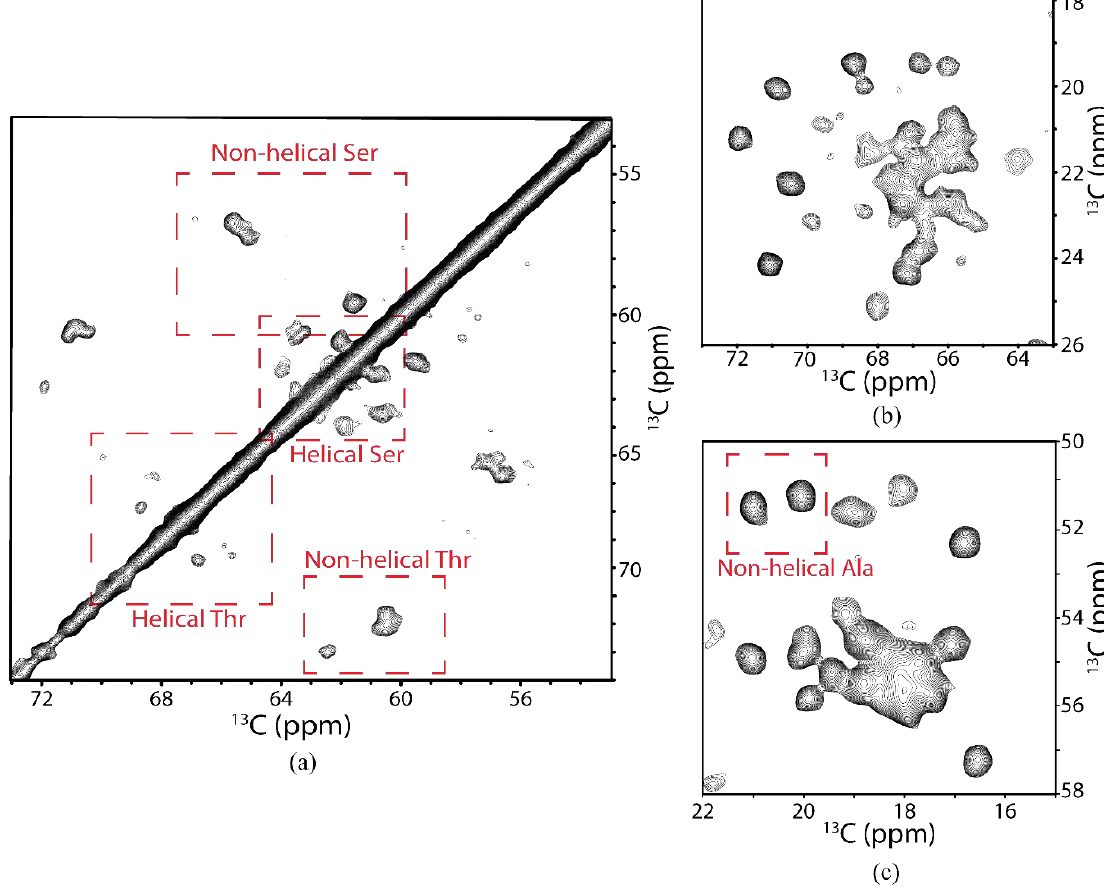
Figure 8. Selected characteristic regions of two-dimensional 13 C– 13 C DARR chemical shift correlation spectrum of 13 C, 15 N-labeled hAQP2 proteolipid complexes. Regions selected to show spectral coverage of ( a ) Ser and Thr CA/CB correlations, ( b ) Thr CA/CG and Thr CB/CG correlations, and ( c ) Ala CA/CB correlations.